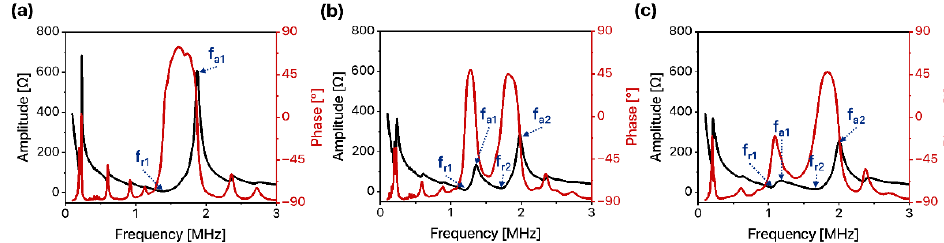
Figure 5. Electrical input impedance of 1D linear ultrasound transducer arrays ( a ) without matching layer, ( b ) with the FPCB matching layer, and ( c ) with the alumina/epoxy matching layer. However, the resonance characteristics of the 1D linear ultrasound transducer array changed with the application of the acoustic matching layer. Multiple resonance peaks were observed as acoustic matching layers were introduced to the 1D linear ultrasound transducer arrays [25]. A 1D linear ultrasound transducer array with an FPCB matching layer exhibited two strong resonances (Figure 5b). The first resonance frequency (f r1 ) and anti-resonance frequency (f a1 ) were 1.14 MHz and 1.32 MHz, respectively. The second res- onance frequency (f r2 ) and anti-resonance frequency (f a2 ) were 1.66 MHz and 1.95 MHz,